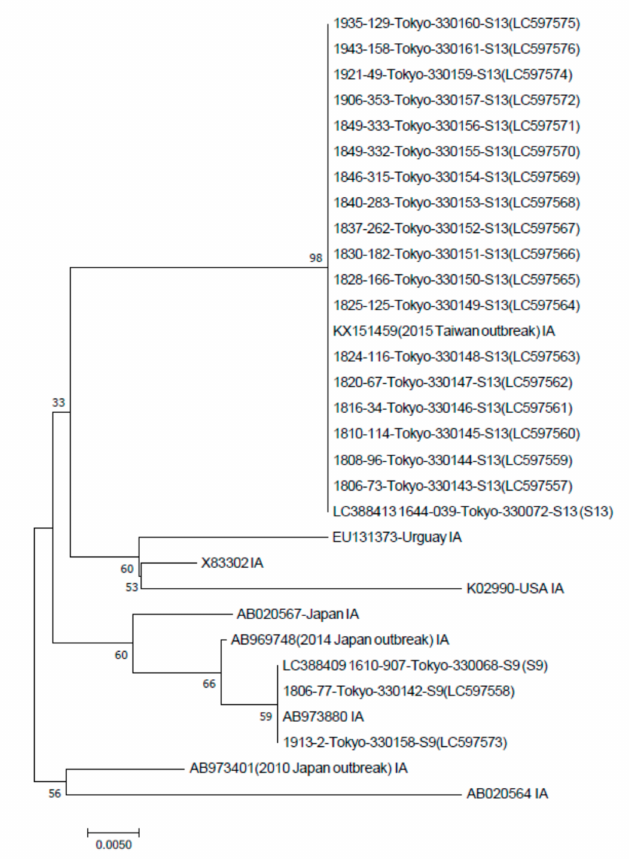
Figure 1. Phylogenetic analysis of the hepatitis A virus (HAV) VP1-2A region (168 bp) in the present study, and previously reported sequences of HAV subgenotype IA. Neighbor-joining methods were performed [15,17]. Accession numbers for the DDBJ/EMBL/GenBank databases are indicated. The HAV isolates in the present study ranged from LC597557 to LC597576 (see Table